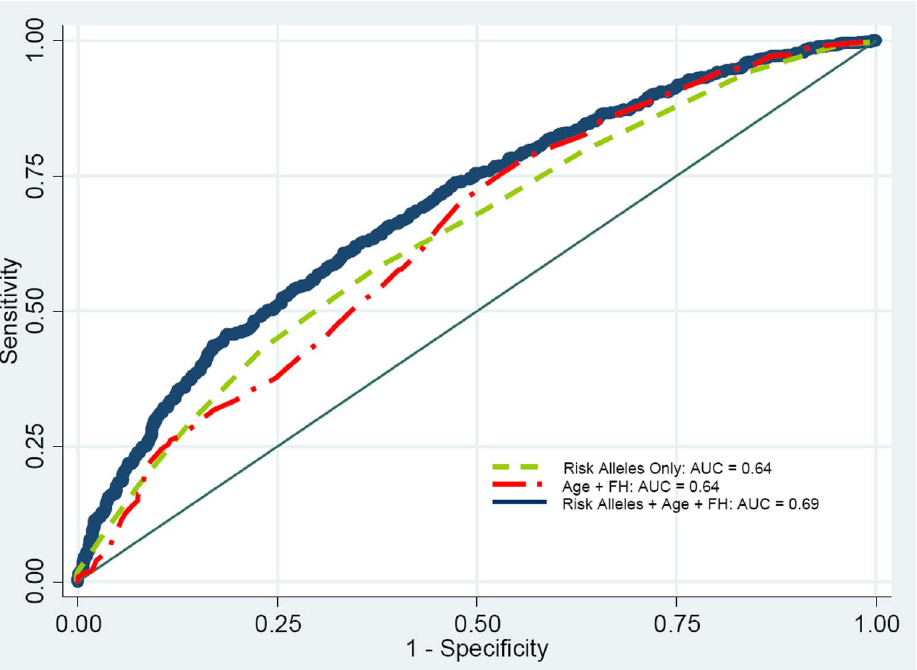
Figure 2. Receiver operating characteristic (ROC) curves for risk prediction of prostate cancer for three different models incorporating cumulative number of risk alleles, age at diagnosis and family history (FH) of prostate cancer.